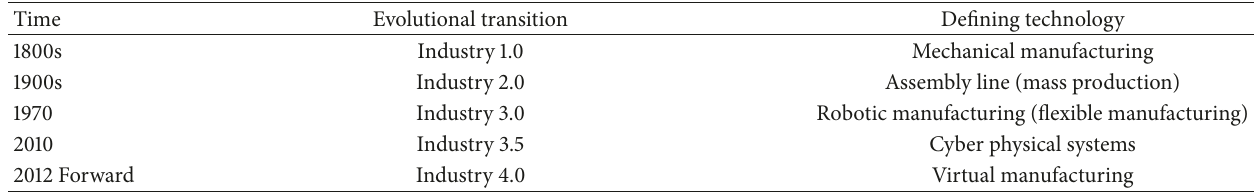
Table 1: Technology evolution from Industry 1.0 to Industry